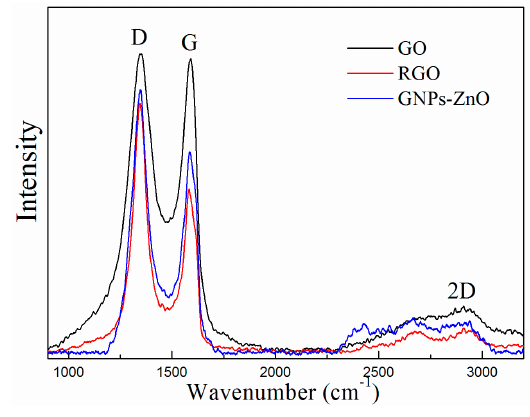
Figure 6. Raman spectrum of GNP-ZnO hybrids.